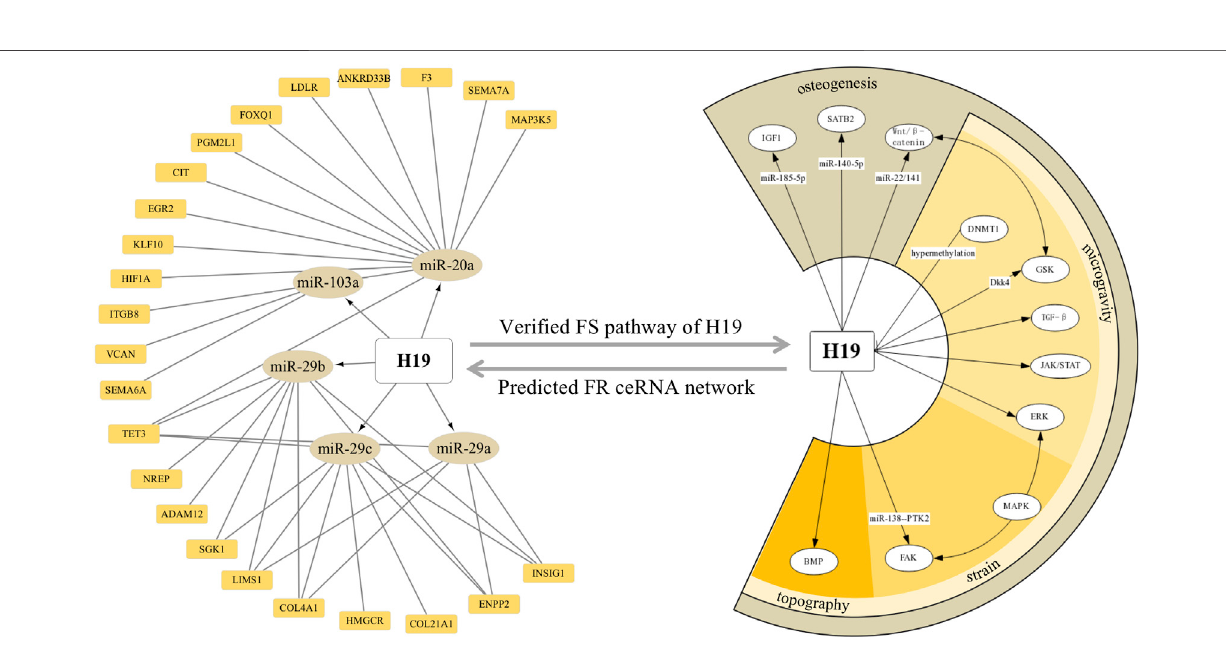
FIGURE 9 | ceRNA network and downstream pathways revealed H19 as a key FS lncRNA confronting the mechanical input. Orange squares and dark yellow ellipses in the left semicircle stands for FS mRNA and CFS miRNA related to H19, respectively. White ellipses in the right semicircle represent the veri fi ed pathway H19 involved in FS condition and osteogenic